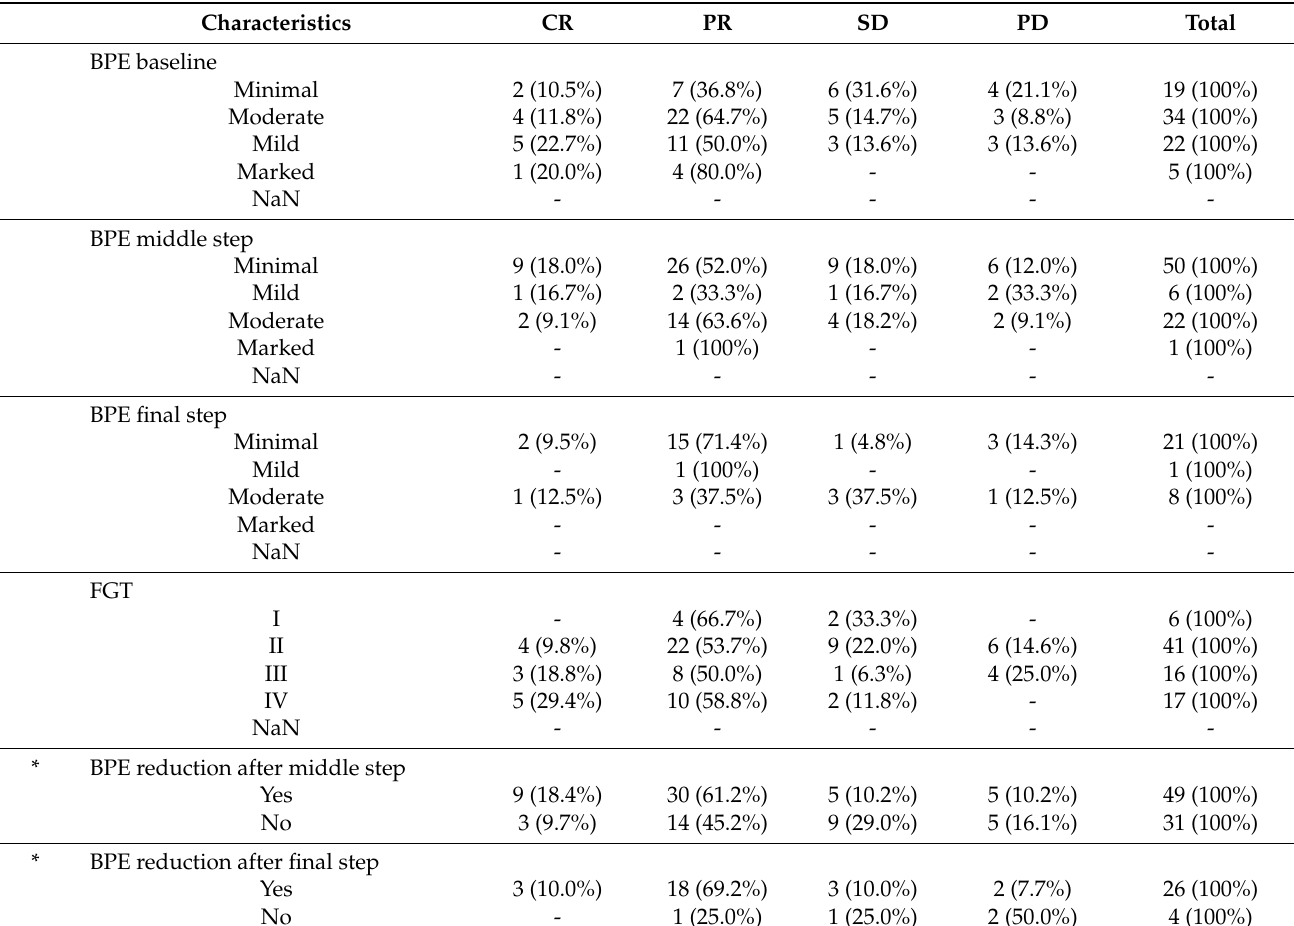
Table 8. Distribution of response to NAC with respect to BPE, FGT, and reduction of BPE after the middle and final step.